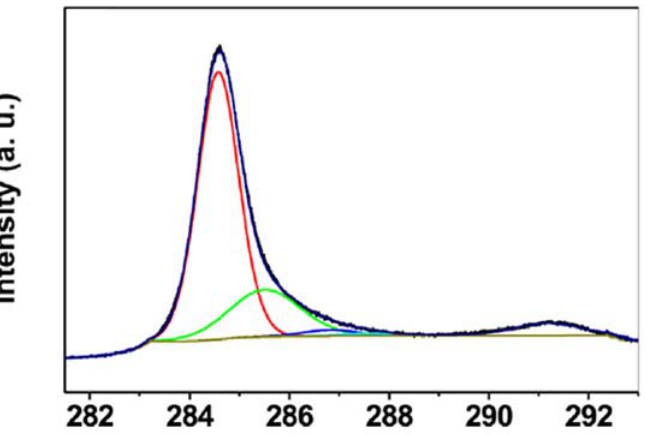
Figure 8. Example of the XPS C1s peak of MWCNT, showing the C=C peak sp 2 (red), the C-C peak sp 3 (green), a C-O peak (blue), and the π – π * transition (situated at 291 eV, but not indicated), cited from [73].